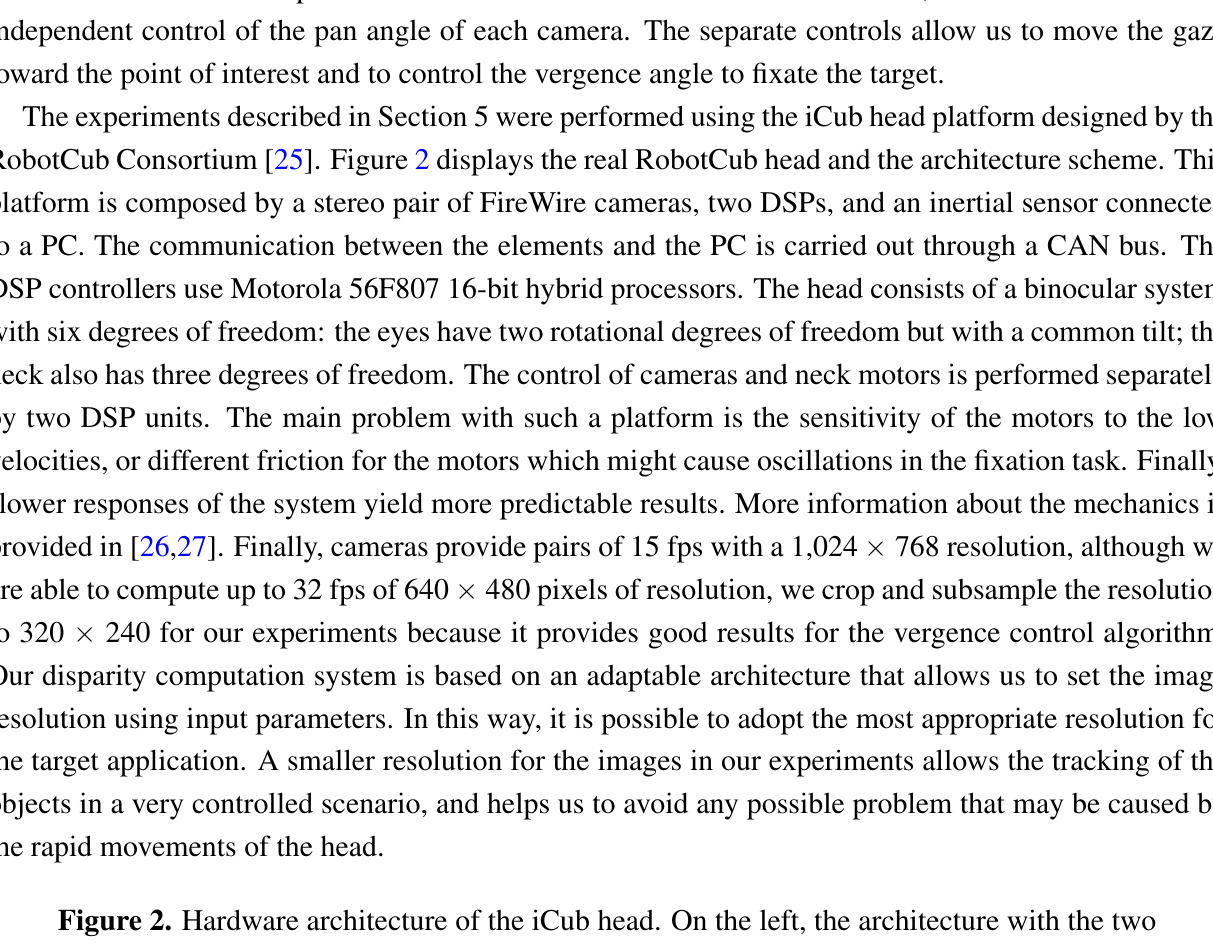
Figure 2. Hardware architecture of the iCub head. On the left, the architecture with the two DSPs, the PC connected to the CAN bus, and the inertial sensor are shown. An image of the head is shown on the